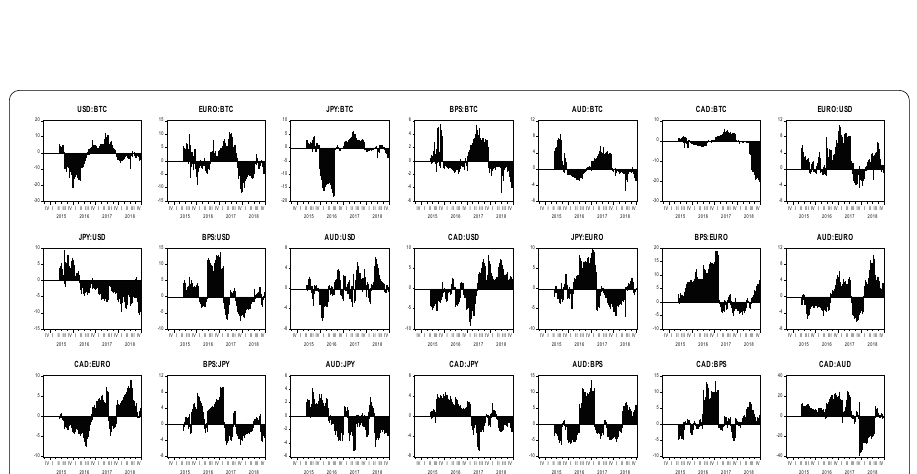
Fig. 8 Directional FROM SAM (250 days rolling window)—Bitcoin markets and foreign exchange pairs of major trading currencies SAM H 2 N , i ←• The Y-axis depicts the volatility spillover values and the X-axis depicts the time